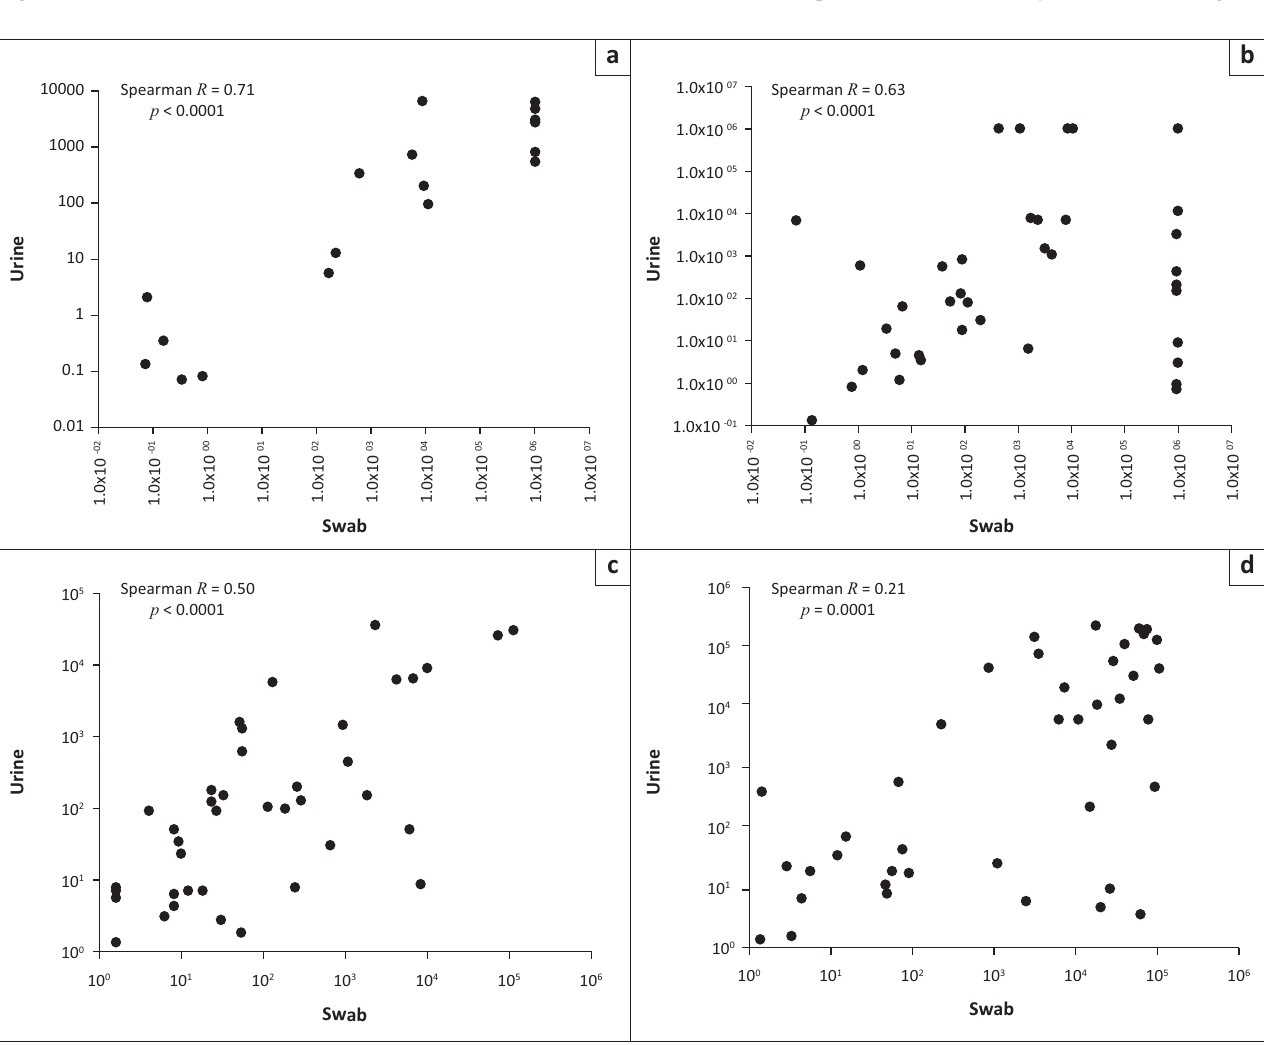
http://www.sajid.co.za